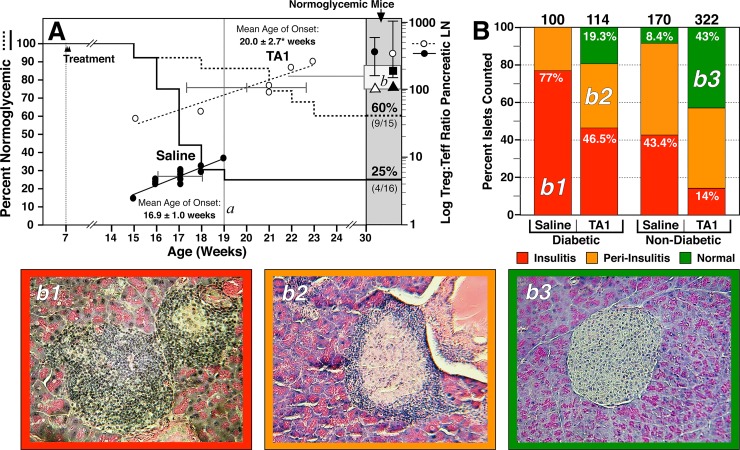
TA1 administration prevents (p≤0.01) or delays T1D (p≤0.01) progression in NOD mice, alters the ratio of Treg:Teff cells and improves islet histology.
Panel A: Mice were treated (i.v.) with either saline or TA1 at 7 weeks of age and blood glucose was measured to a maximum of 30 weeks. Shown are the percentage of animals remaining normoglycemic (left axis). As shown, only 25% of control mice were normoglycemic at week 19 (line a) while 87% of TA1 remained normal. At 30 weeks, 25% of untreated mice and 60% of TA1-treated mice remained normoglycemic. Conversion to T1D correlated in both groups with the log Treg:Teff ratio (left axis). TA1 significantly increased the Treg:Teff ratio in all animals (Diabetic and non-diabetic). The Treg:Teff ratio of normoglycemic saline (● mean 286; range 170–680) and TA1 (○ mean 255; range 140–1040) treated mice (shade box; right) were similar but significantly (p<0.001) higher than diabetic mice. Analysis of the Treg:Teff ratio of diabetic and non-diabetic saline and TA1 mice suggests that an inexact threshold level (box b) in the Treg:Teff ratio may exist for protection against progression to T1D. Also shown are the Treg:Teff ratios for immunocompetent C57Bl/6 and Balb/c mice (Δ, 91.5; ■, 198; respectively) and the asymptomatic 7 week old NOD mice (▲;103). Diabetic tissues were harvested at time of conversion, non-diabetic tissues were harvested at week 30. Diabetic values are the mean ± SD of 12 saline and 6 TA1 treated NOD mice. For diabetic animals (saline and TA1 treated) the mean age of onset ± SD is shown via both text and horizontal bar. Non-diabetic results are the mean ± SD of 4 saline and 9 TA1 treated NOD mice. Panel B: TA1 inhibits pancreatic islet insulitis as demonstrated by the increased number of normal (b3) and peri-insulitis (b2) islets relative to control NOD mice. Untreated NOD mice exhibited virtually no normal islets (either in diabetic or non-diabetic mice) with a heavy preponderance of overt insulitis (b1). The numbers shown at the top of each column represent the number of individual islets graded per condition from a minimum of 5 animals per group.